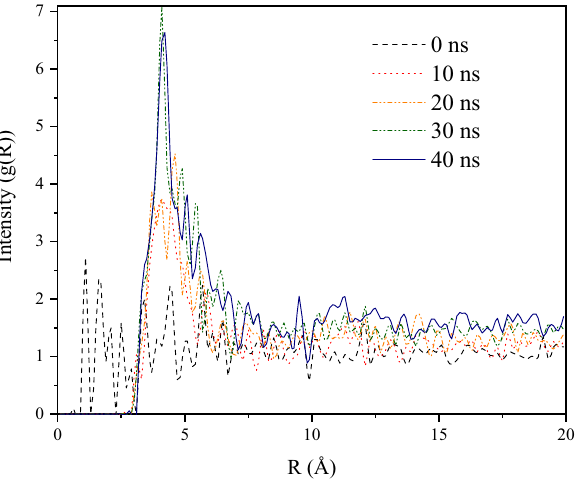
Figure 8. Radial distribution function analyses for CO 2 (C–C RDF) at different simulation times (at 298 K under 10